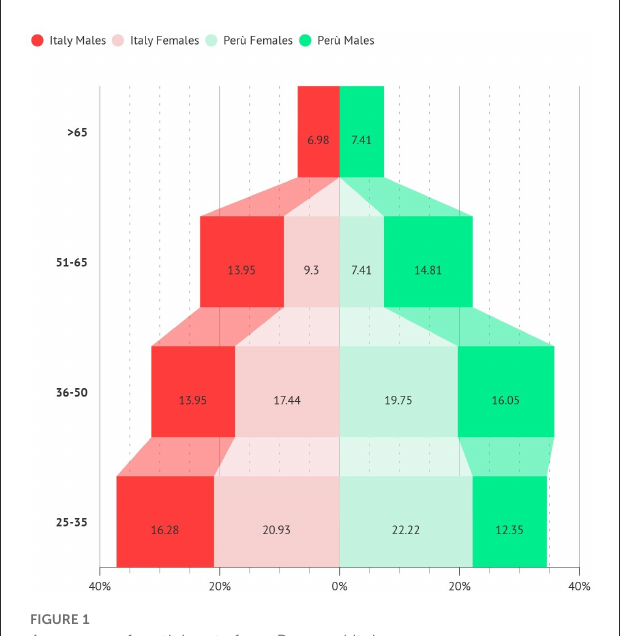
FIGURE1 Age range of participants from Peru and Italy.